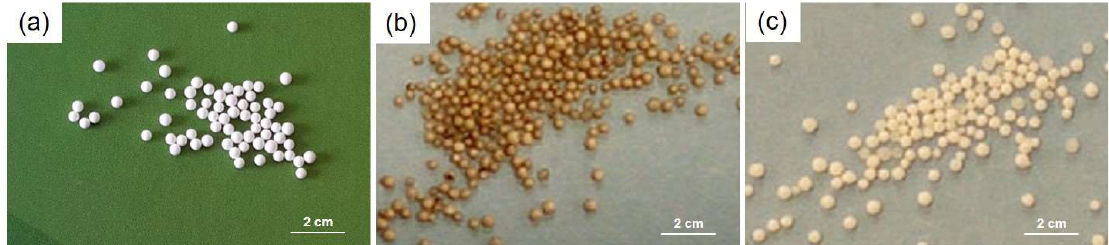
Figure 3. Color and size of ( a ) PLGA microspheres, ( b ) PLGA@PDA microspheres and ( c ) PLGA@PDA/PEI microspheres.